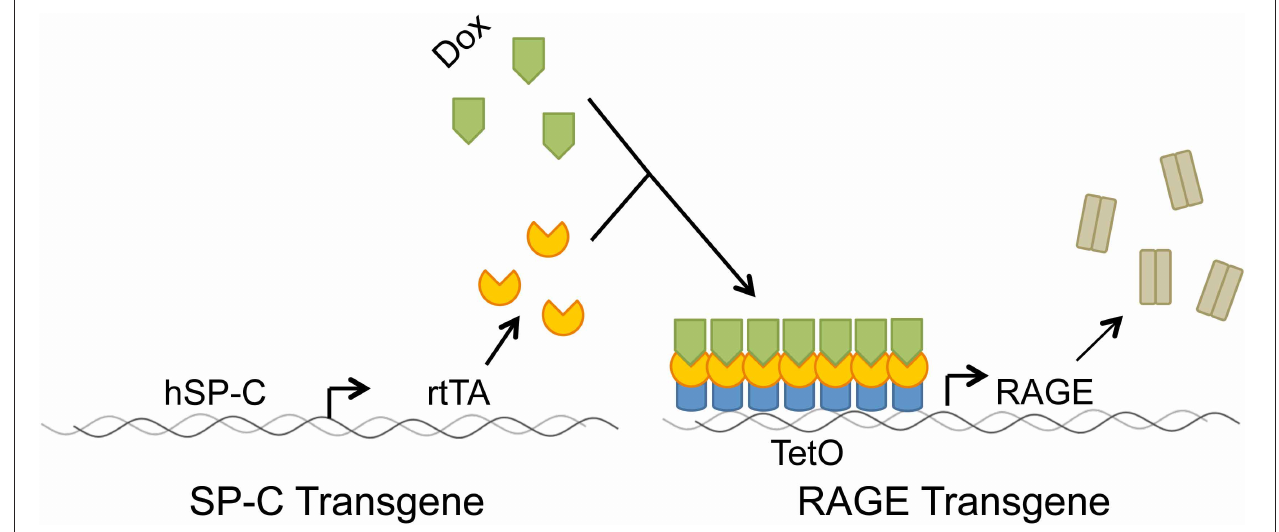
FIGURE 2 | Full length RAGE was over-expressed in alveolar type (AT) II cells by obtaining progeny from two transgenic lines of mice. The reverse tetracycline transactivator (rtTA) was produced under the control of